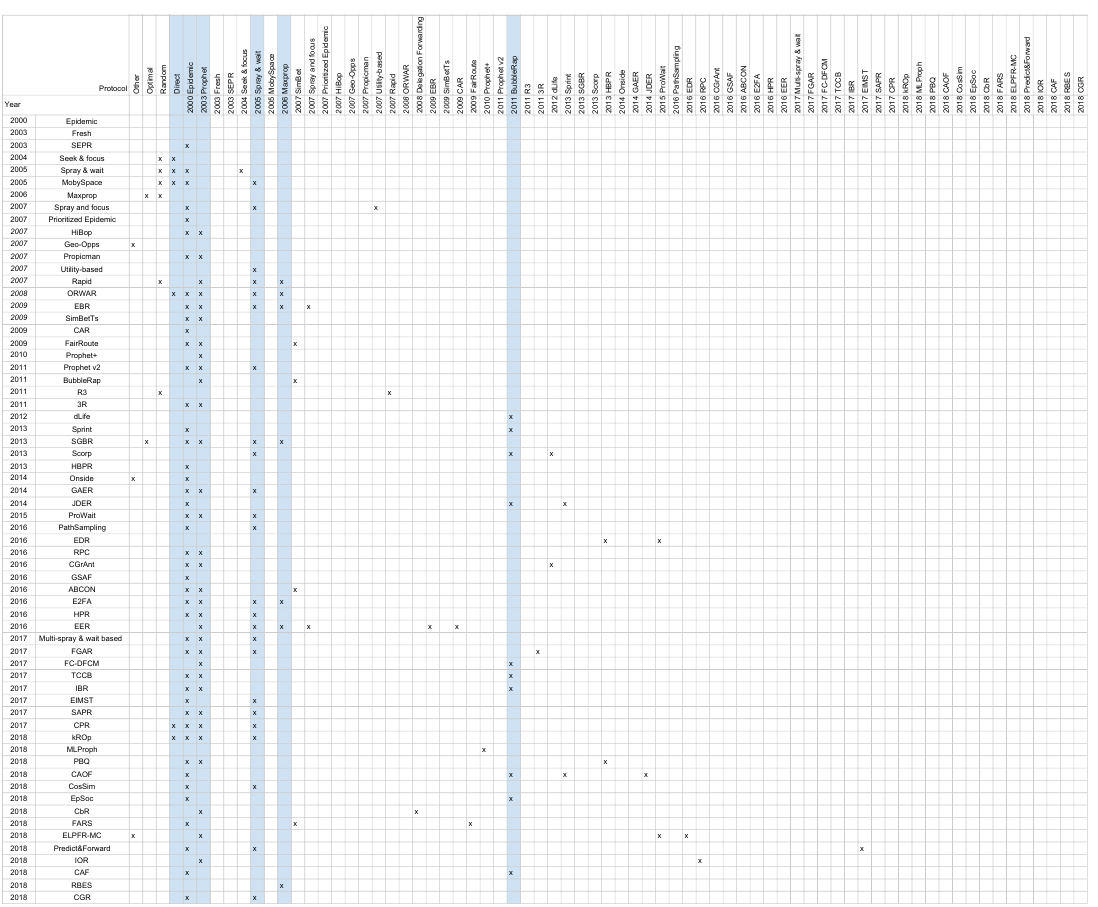
Figure A1. Comparative studies between the protocols surveyed in the paper. Protocols